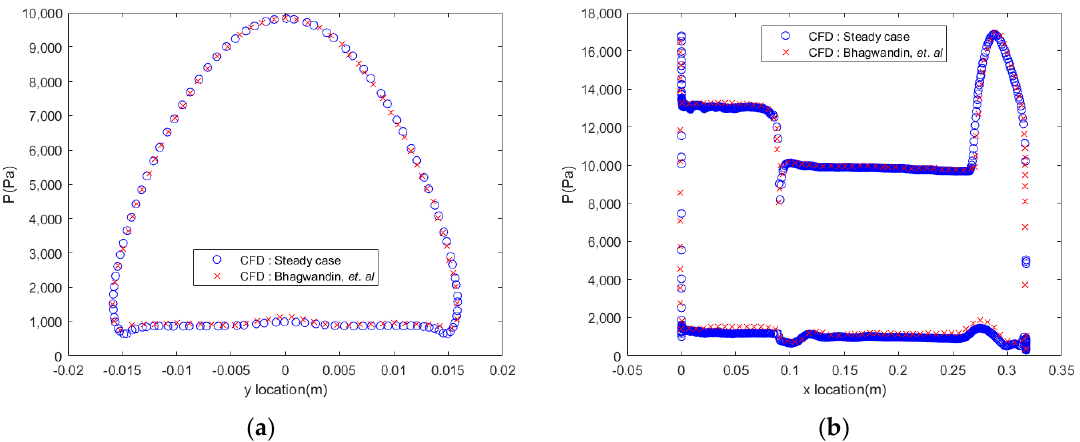
Figure 10. Static pressure (P) profile of ( a ) circumferential pressure at c.g.; ( b ) Axial pressure from nose to base along with the symmetry plane cut.